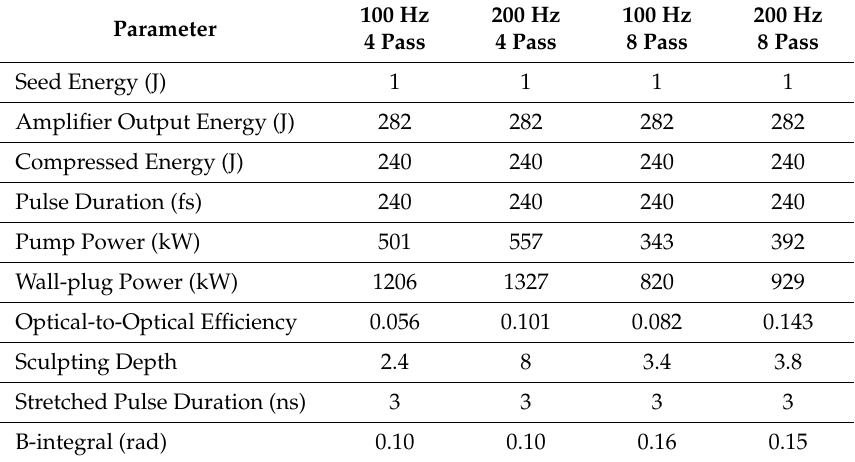
Table 2. Optimized performance of 100 Hz and 200 Hz Tm:YLF MPE